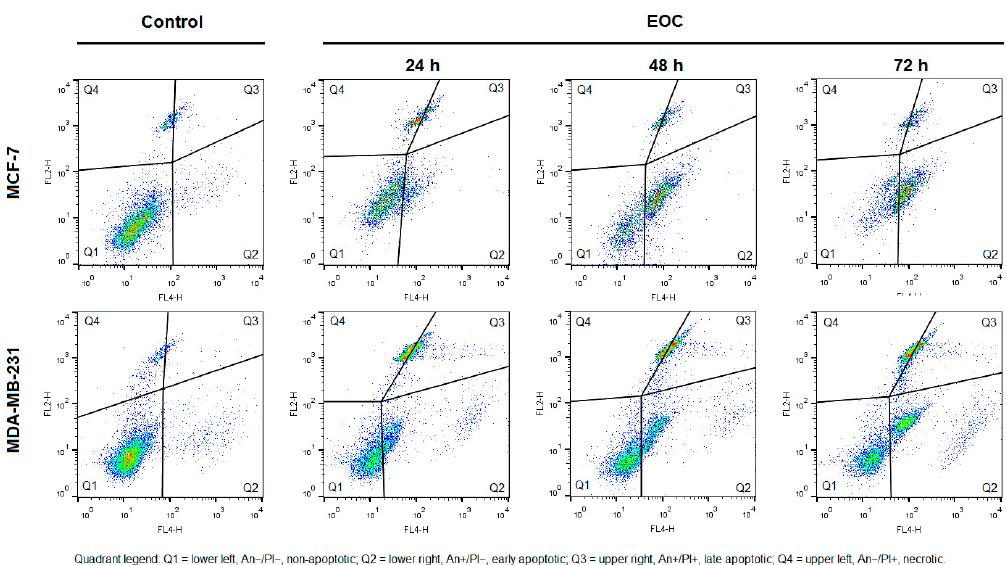
Figure 11. Representative diagrams of apoptotic cell diversification in MCF-7 and MDA-MB-231 cells after EOC treatment (1:25,000, 1:65,000).